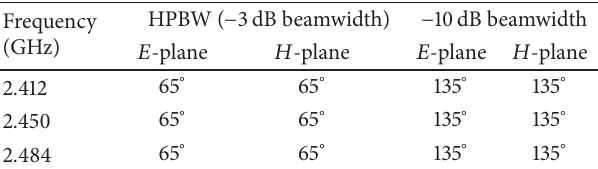
Table 6: Measured beamwidths at − 3 dB and at − 10dB of